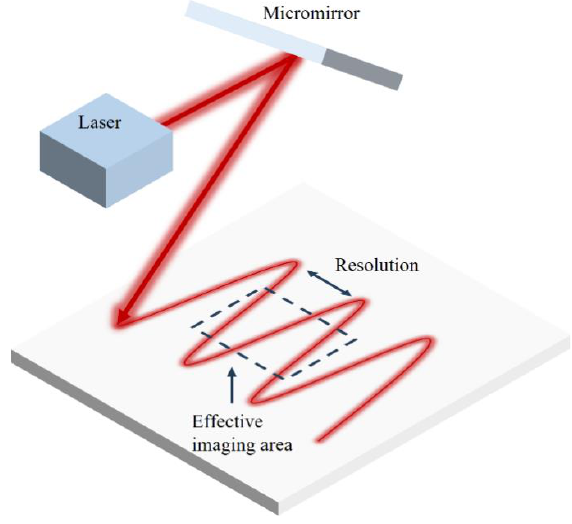
Figure 6. The schematic of Linescan mode.